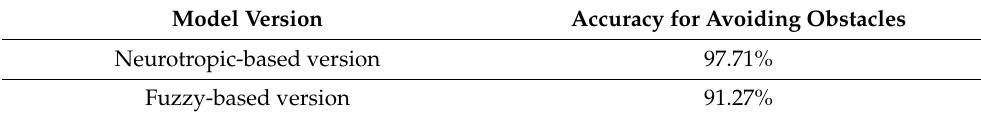
Table 5. Evaluation results for the tested dataset.